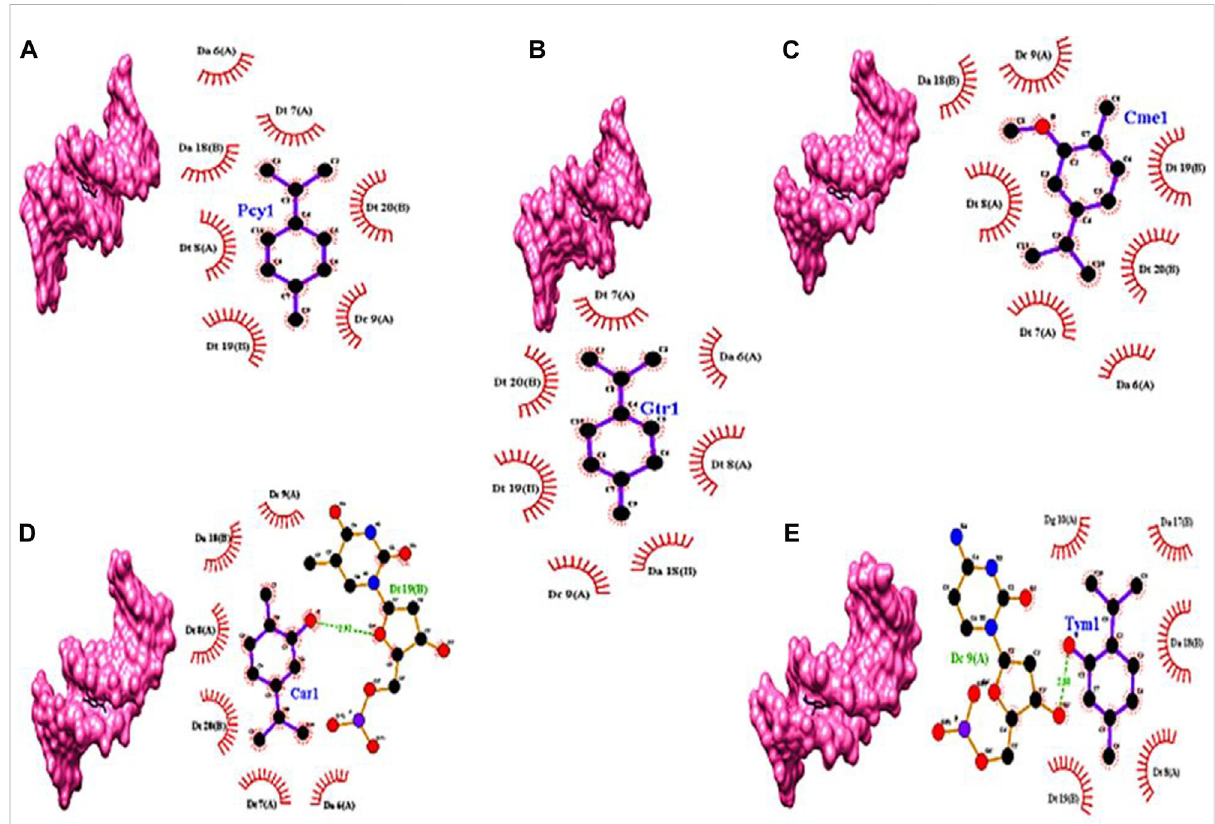
FIGURE 6 Docking models of (A) p-cymene (Pcy1), (B) γ -terpinene (Gtr1), (C) carvacrol methyl ether (Cme1), (D) carvacrol (Car1), and (E) thymol (Tym1) with DNA double-helix (PDB ID: 1BNA) represented in Chimera software and 2D presentation of the docked models of in Ligplot + . Residues of the DNAmoleculeinvolvedinhydrogenbondsandhydrophobicinteractionswiththechemicalsarerepresentedbythedashedgreenlinesandbrick-red arcs,